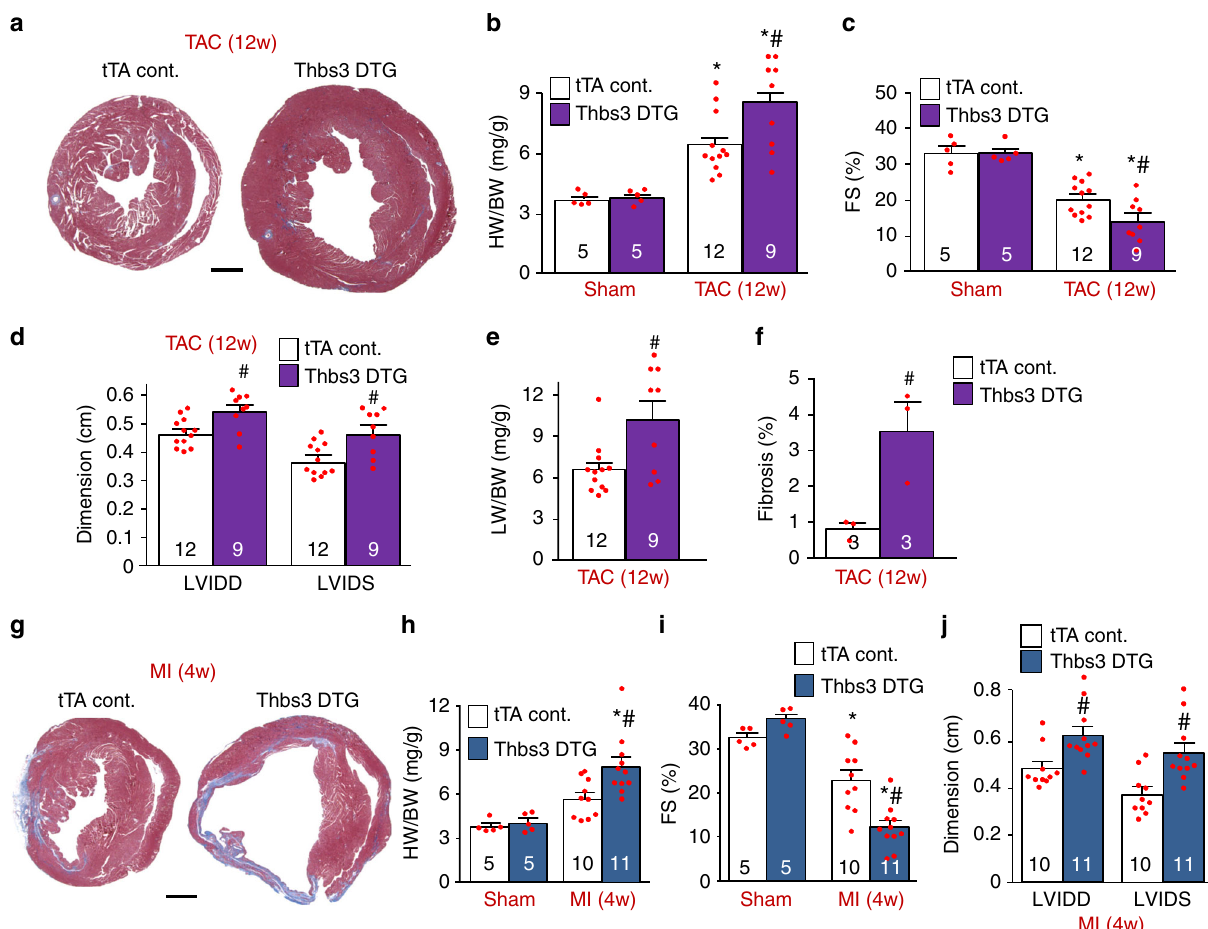
Fig. 2 Cardiac-speci fi c Thbs3 overexpression increases pathology after injury. a Low magni fi cation images of tTA control and Thbs3 DTG cardiac histological sections stained with Masson ’ s trichrome 12 weeks after TAC surgery. Scale bar is 1 mm. b Heart weight-to-body weight (HW/BW) ratio 12 weeks after TAC or sham surgery. c Echocardiography measured fractional shortening (FS) percentage and d left ventricular dimensions in diastole (LVIDD) and systole (LVIDS). e Pulmonary edema was analyzed by lung weight-to-body weight (LW/BW) ratios in the indicated groups of mice. f Percentage of fi brotic area was quanti fi ed from heart sections stained with Masson ’ s trichrome. g Low magni fi cation histological images of tTA control and Thbs3 DTG hearts, 4 weeks after MI surgery stained with Masson ’ s trichrome. Scale bar is 1 mm. h HW/BW ratio 4 weeks after MI or Sham surgery in the indicated groups of mice. i Fractional shortening (FS) percentage and j LVIDD and LVIDS measured by echocardiography. Numbers of animals analyzed in each group for each procedure is indicated on the histograms. * P < 0.05 versus tTA control sham; # P < 0.05 versus tTA TAC or MI. Statistical analysis was performed using one-way ANOVA and Turkey multiple comparisons test. Error bars are + / − standard error of the mean and number of mice used in